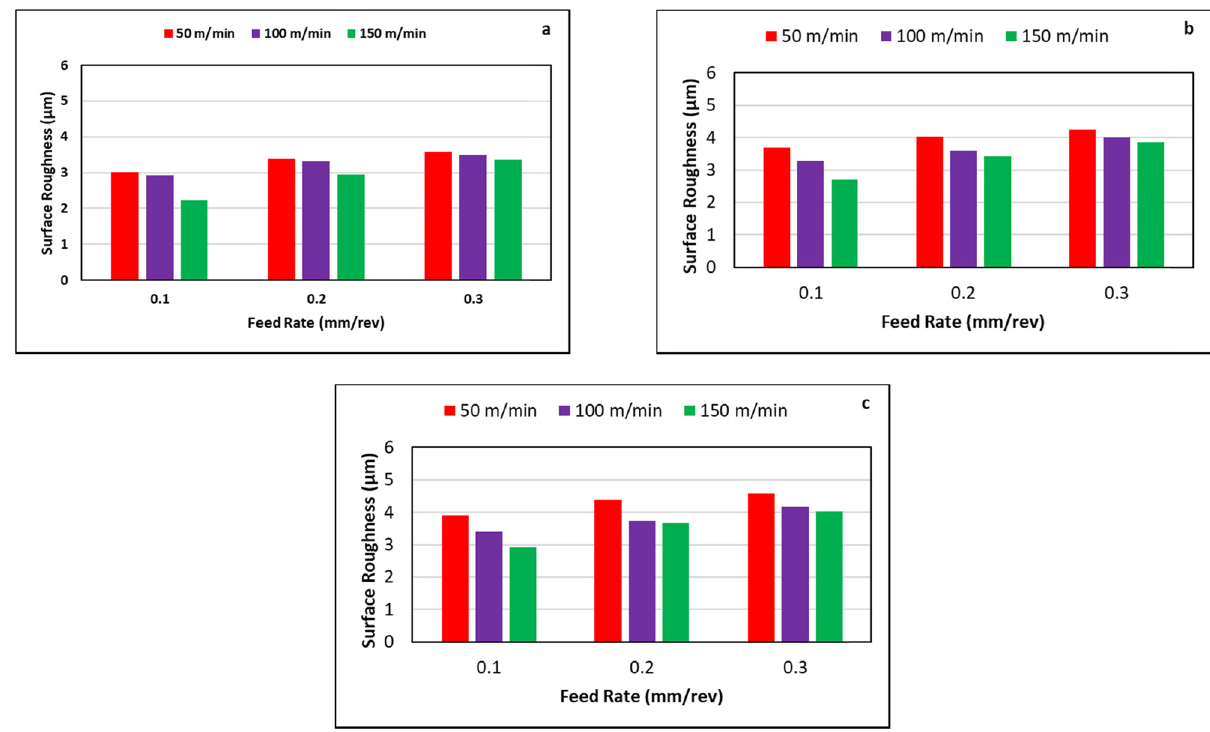
Figure 8: In fl uence of feed rate on surface roughness at 30° fi ber orientation: ( a ) depth of cut 1 mm, ( b ) depth of cut 2 mm, and ( c ) depth of cut 3